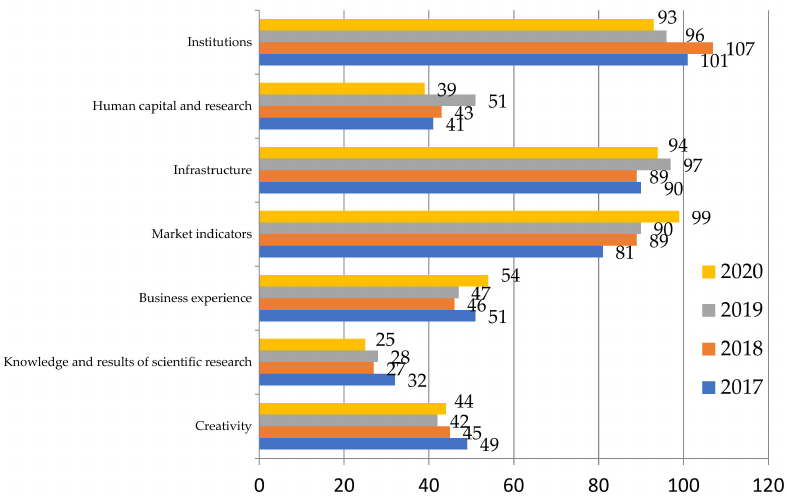
Figure 3. Dynamics of GII indices for Ukraine in 2017–2021. Reproduced with permission from [38]. Copyright 2021, World Intellectual Property